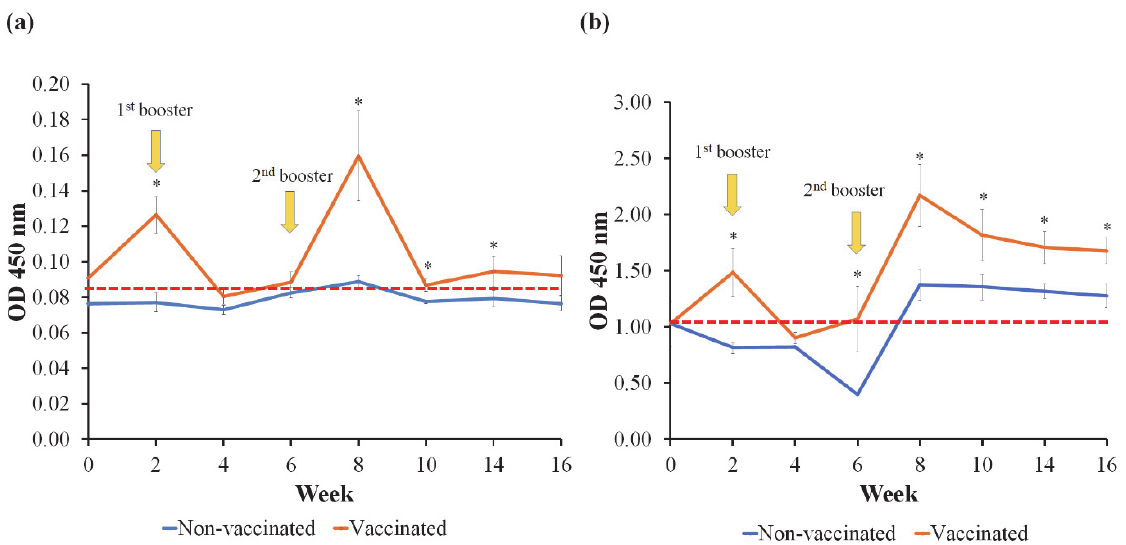
Figure 5. The mucus ( a ) and serum ( b ) IgM responses following vaccination with feed-based inacti- vated vaccine against vibriosis. The non-vaccinated fish were fed a commercial pellet formulated with PBS. Asterisks (*) indicate significant differences at p < 0.05 between the vaccinated and non- vaccinated